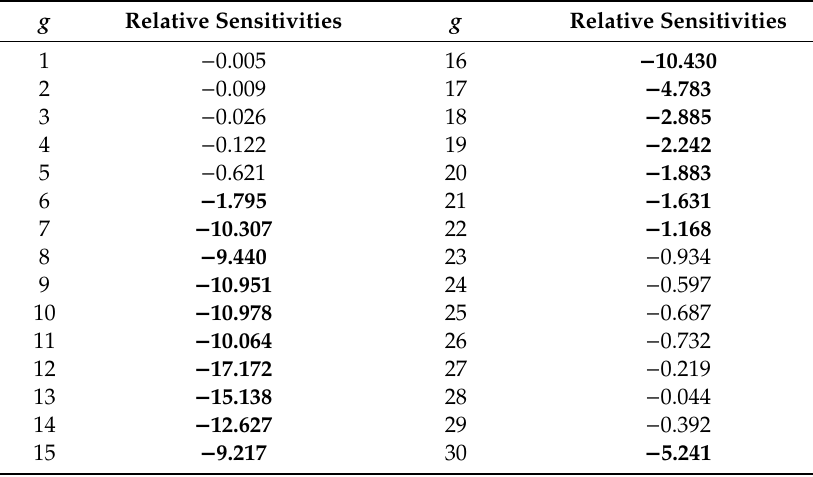
(cid:16) (cid:17) N 1,1 , σ g , g = 1, ... ,30. t ,1